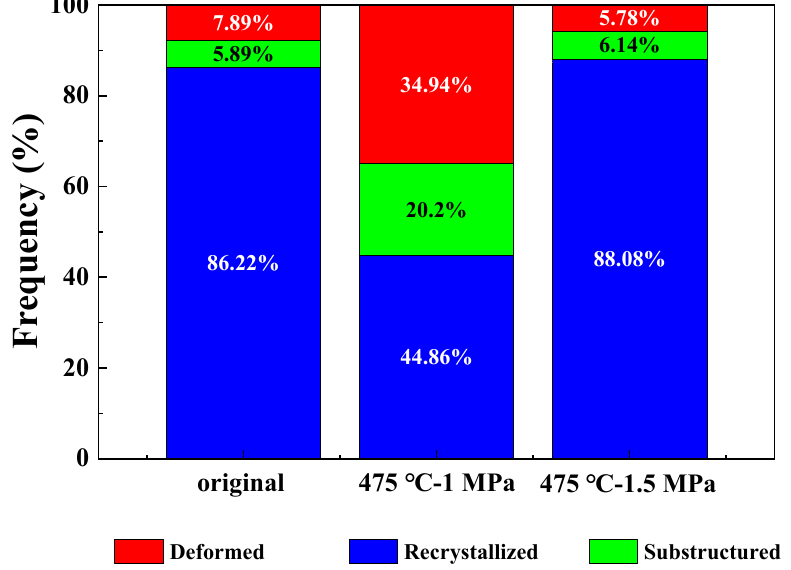
Figure 9. The microstructure of the materials under different pressures at 475 °C.